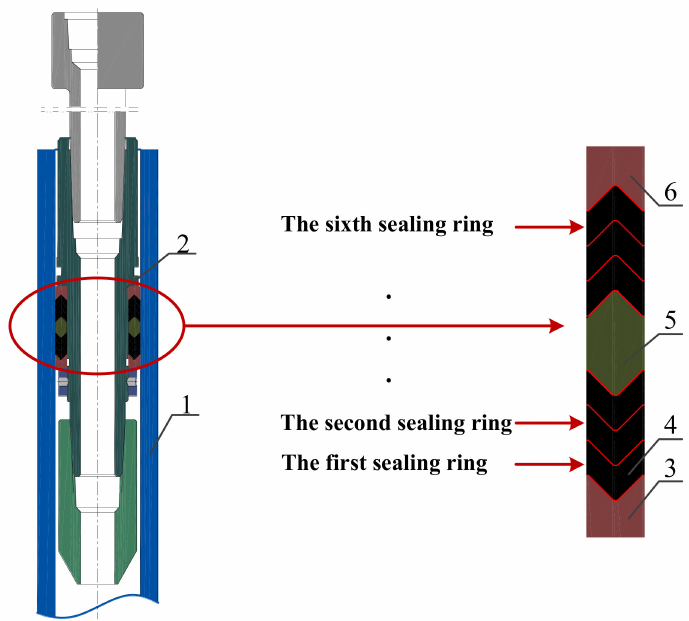
Figure 1. Inserted sealing tool: 1-casing pipe, 2-central pipe, 3-press ring, 4-sealing ring, 5-spacer ring, 6-support